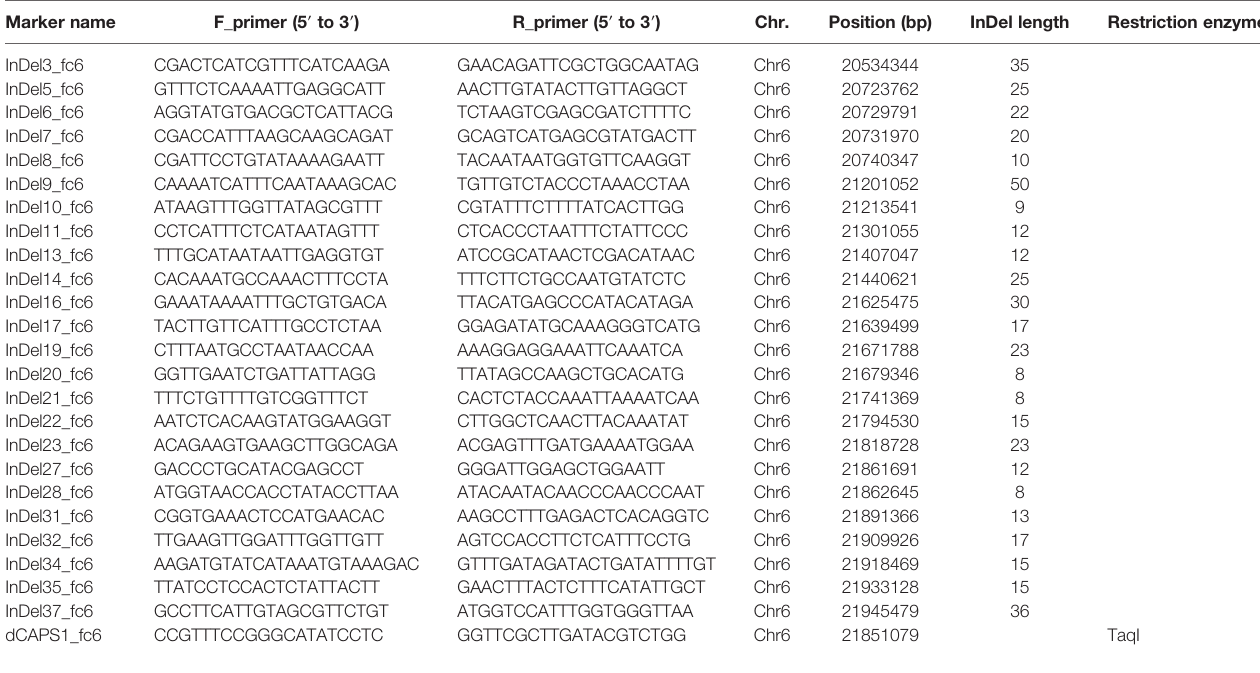
TABLE 2 | The primer pair information for the PCR-based